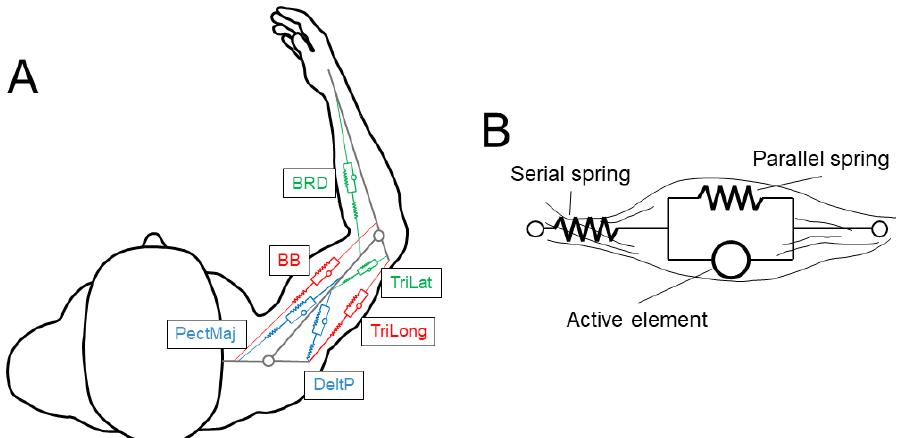
Figure 1. ( A ). The elbow – shoulder musculoskeletal model comprising 2 joints and 6 muscles (shoul- der monoarticular in blue, elbow monoarticular in green, and biarticular in red). ( B ). The Hill muscle model, which approximated each muscle, is composed of three elements: an active element, a spring in parallel with the active element, and a spring in series with the active element.